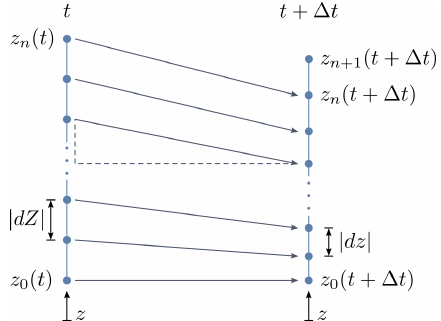
Figure A1. Principle of grid evolution. Left: grid at time t . Right: updated grid at time t + (cid:49)t . The grid points move at the grid point velocity v b , which is equal to the material flow velocity v . At time t + (cid:49)t , an additional grid point z n + 1 representing accumu- lation is added. Distances between neighboring grid points can be understood as material line elements | d Z | and | d z | in the reference and in the current configuration,